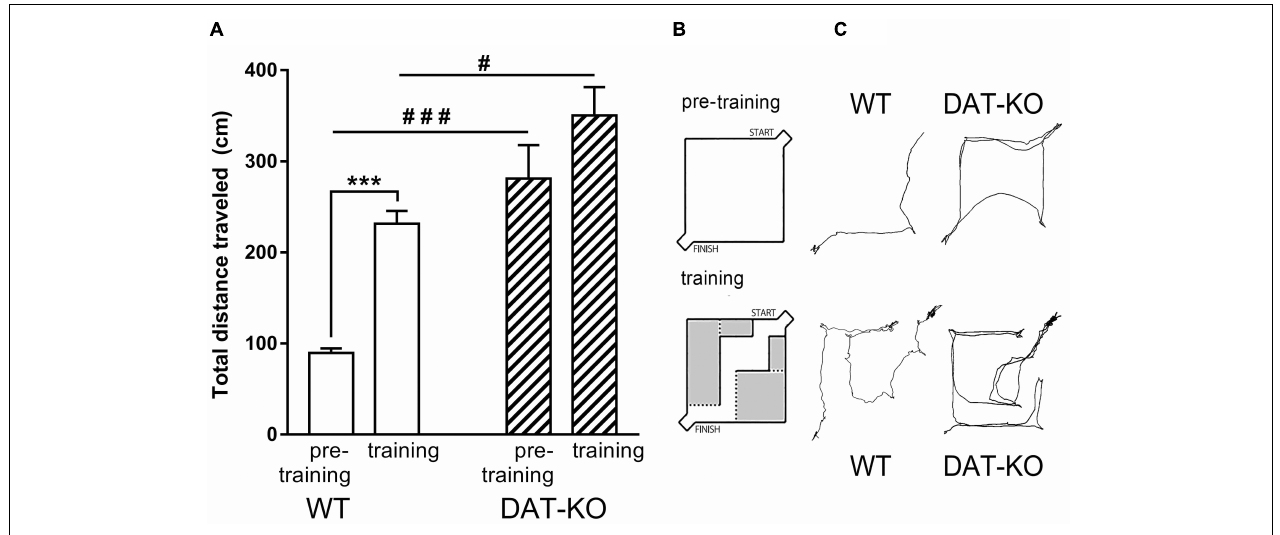
FIGURE 2 | The distances traveled during pre-training and training periods in WT and DAT-KO rats. (A) The distances traveled during 30c, # p < 0.05; ### p < 0.001; one-way Kruskal–Wallis test combined with Dunn’s multiple-comparison post hoc test; *** p < 0.001; Mann Whitney paired test. (B) The wall-less arena in pre-training period and arena in training period. (C) Comparison of visual tracking samples; WT, wild-type; DAT-KO, dopamine transporter knockout